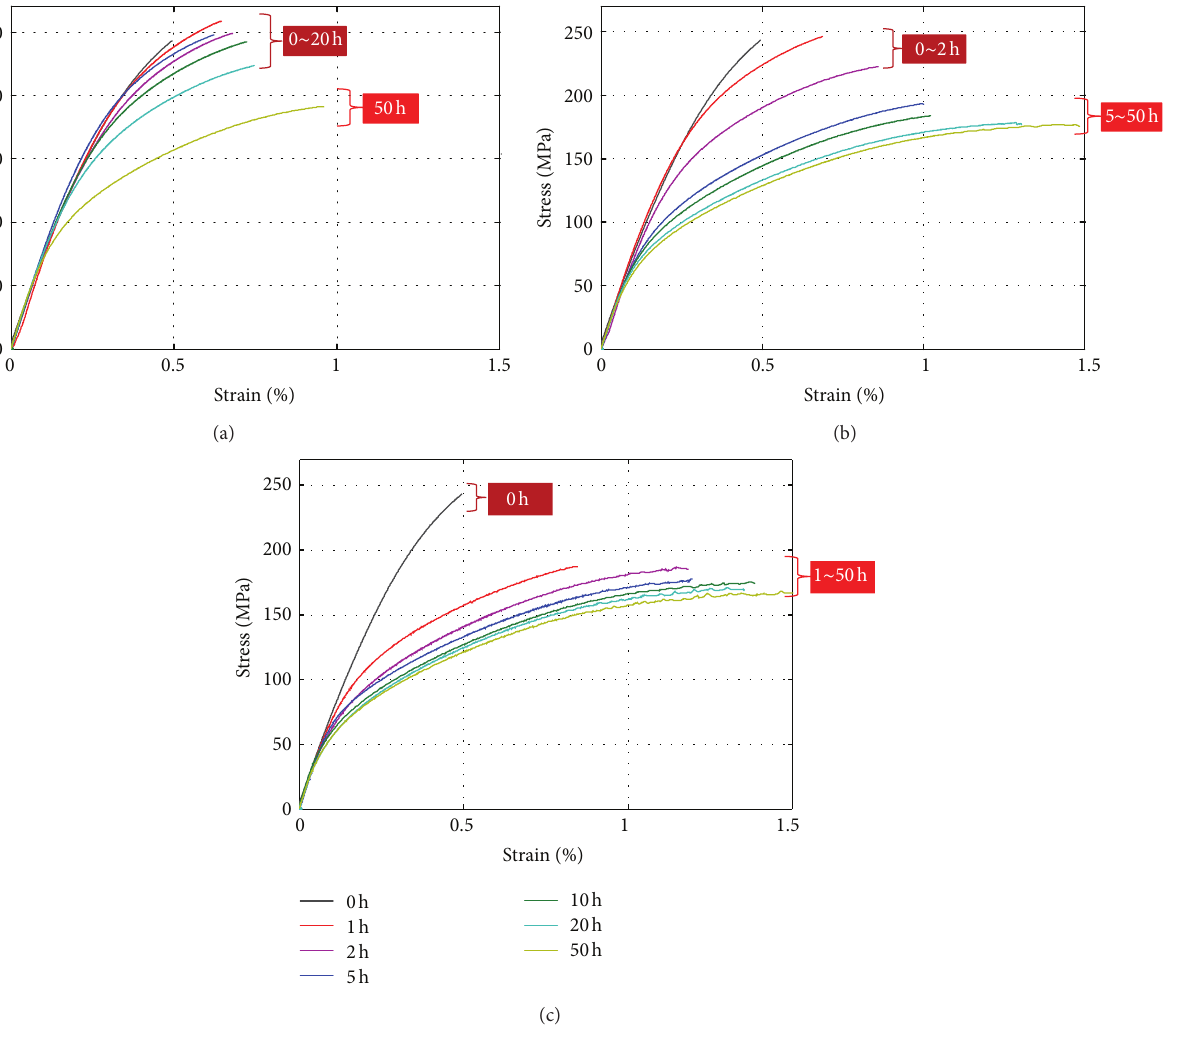
Figure 4: Stress-strain curve obtained from the tensile test for three heating temperatures: (a) 250 ∘ C, (b) 300 ∘ C, and (c) 350 ∘ C.